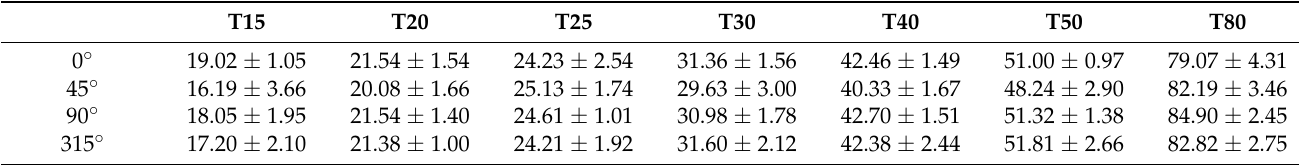
Table 5. Track width obtained after printing with M5 ink, three layers, and a mesh of 90 threads/cm as a function of orientation. Units: